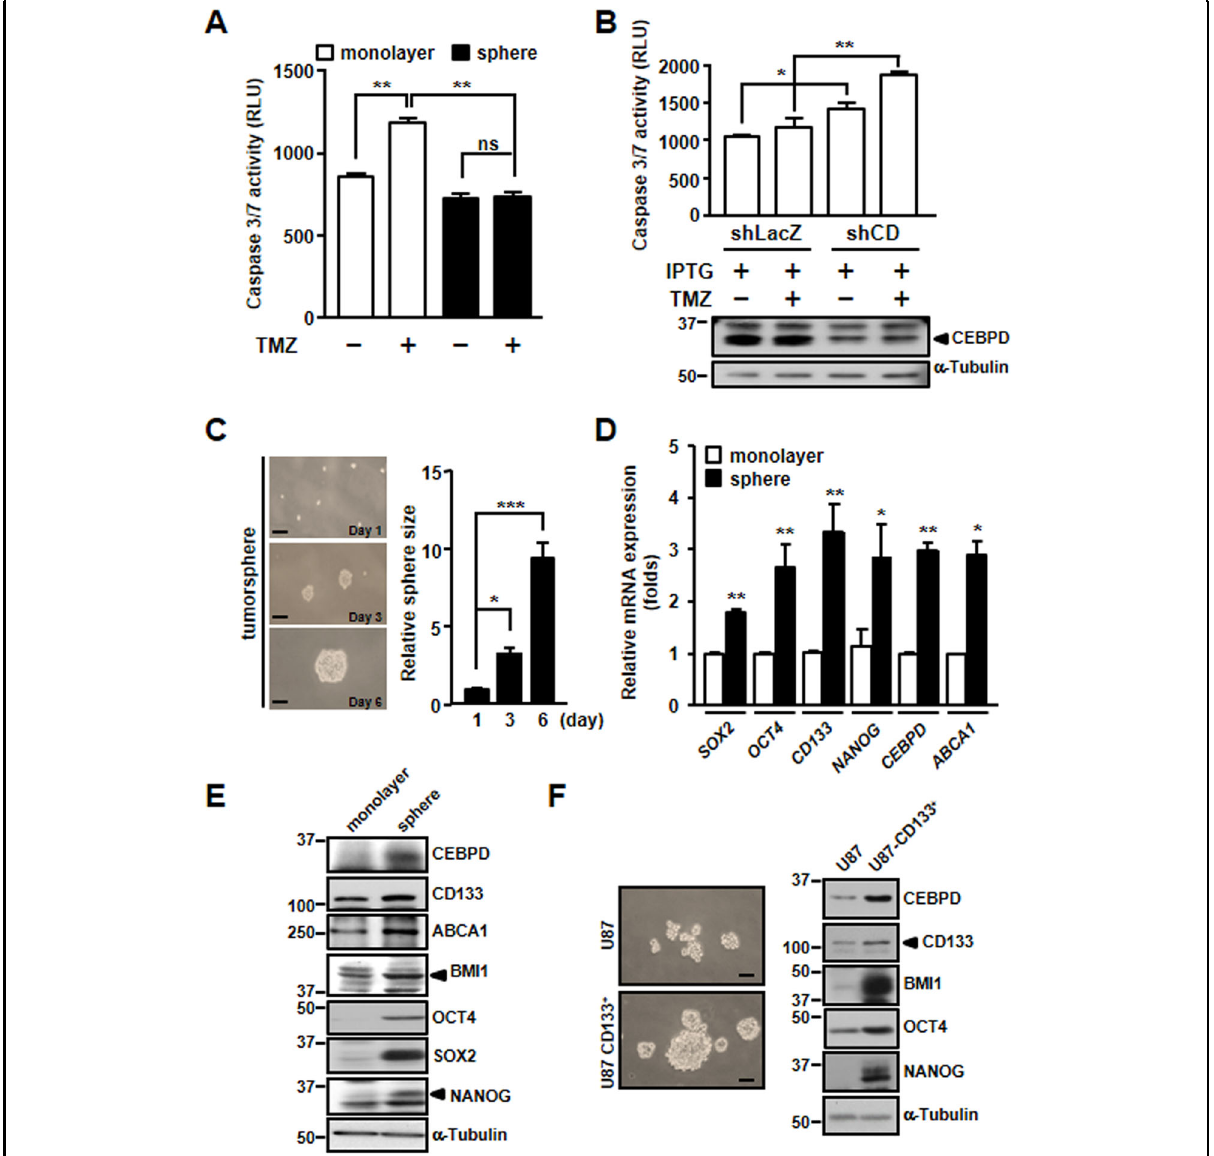
Fig. 2 CEBPD is involved in intrinsic TMZ resistance of GSCs. A Caspase 3/7 activity is decreased in TMZ-treated GSCs. U87MG cells were cultured in stem cell medium for 3 days to form spheroids and treated with 50 μ M TMZ for 72 h. The caspase 3/7 activity was detected by the Caspase-Glo ®